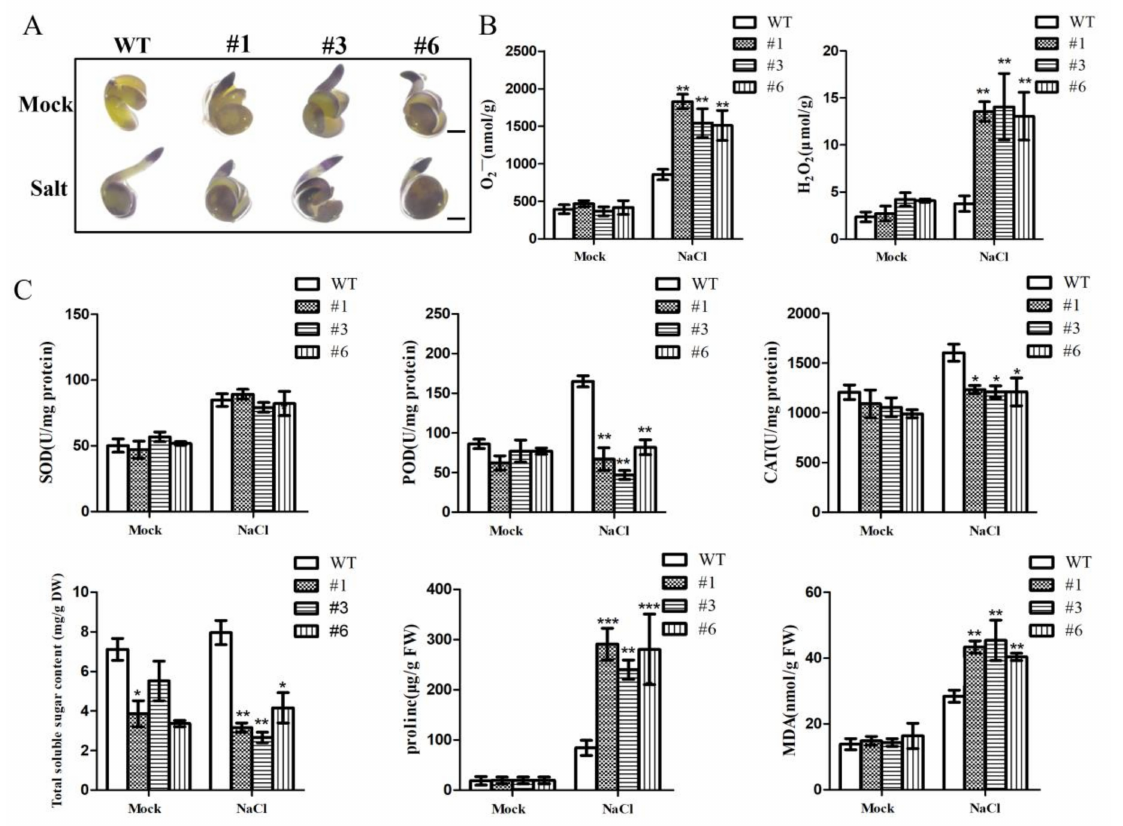
Figure 6. ROS activity analysis during seed germination. ( A ) NBT staining analysis content of O 2 •− . ( B ) O 2 •− and H 2 O 2 content analysis. ( C ) Activities of SOD, POD, CAT, soluble sugar content, proline and MDA. The values represent the means ± SE of three independent experiments. (*** p < 0.001, ** p < 0.01 and * p <